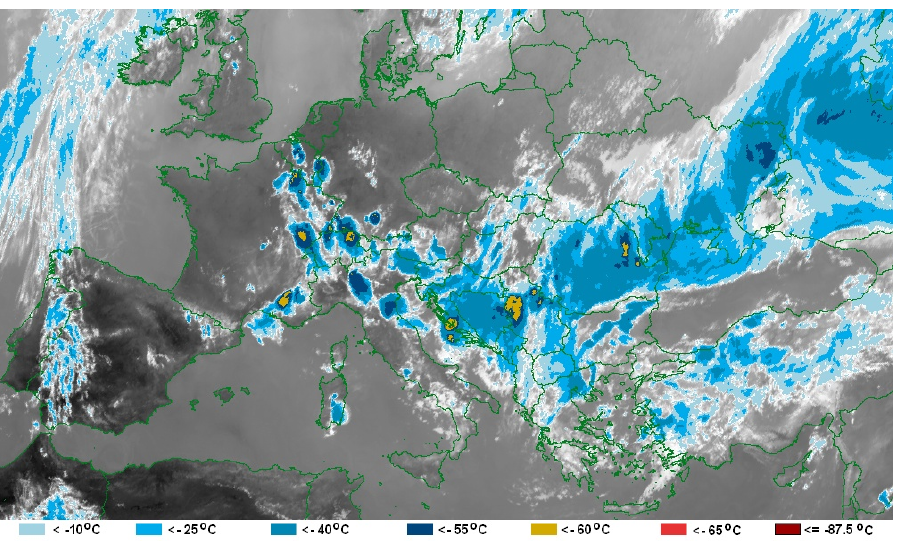
Figure 9 – MSG1 RGB satellite image of the cloud temperature at 5 pm